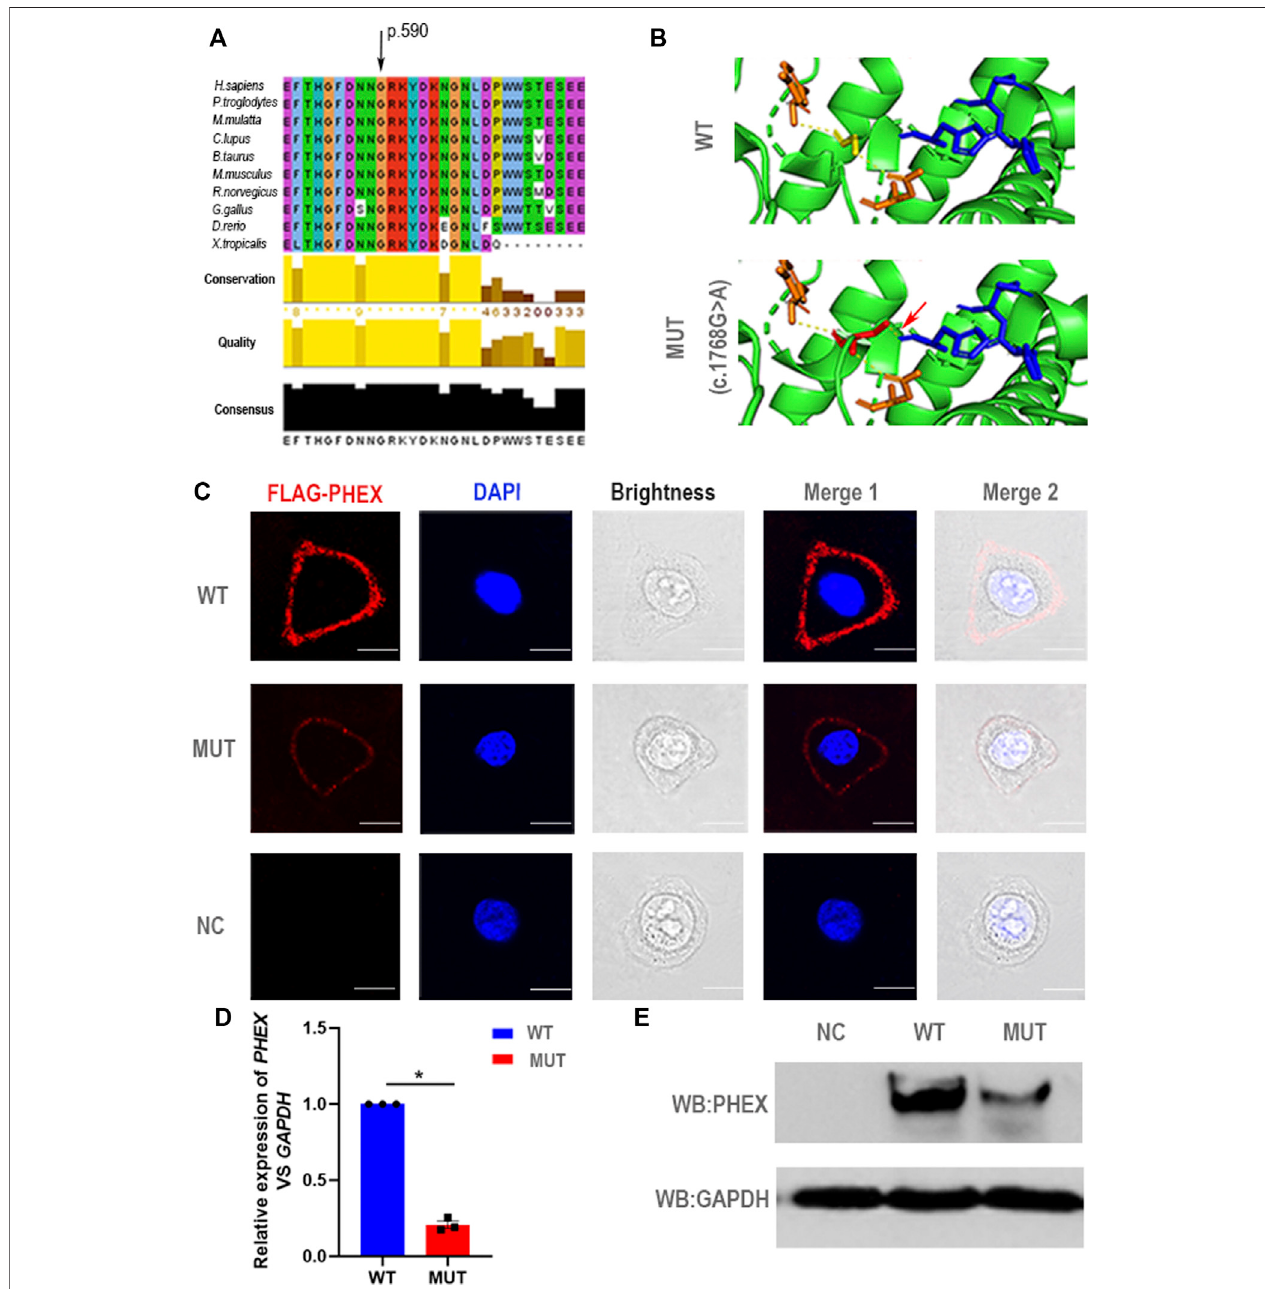
FIGURE3| Negativeeffect ofthenovelmutationin PHE X. (A) Themutant positionwedetected ishighly conserved amongmany species. (B) Structuralillustration of the missense mutation in PHEX . The mutation site in the wild-type PHEX protein model (WT) and mutant PHEX protein model (MUT) are shown as sticks and highlighted in yellow and red. The interrelated putative zinc-binding sites are also represented by sticks and colored in blue. The polar contacts of thetargetresidues are shownasyellowdashedlines,andrelativeaminoacidsareshownasorangesticks.Inthewild-typeprotein,Gly590formstwopolarcontactspredictedbyPyMOL; while in the mutant protein, Ser590 forms three polar contacts due to the addition of one polar contact with His584 that was deemed to be a zinc-binding site predicted byPyMOL. (C) Theimmuno fl uorescentdistributionofPHEXprotein.ThedeclineexpressionlevelofPHEXproteinwasnotedusingimmuno fl uorescencestainingofHeLa cells transfected with mutant- PHEX plasmid compared to cells transfected with WT- PHEX plasmid (red, FLAG-PHEX; blue, DAPI). Scale bars represent 10 μ m. Three independent experiments were performed. (D) Using qPCR, we observed that PHEX mRNA expression levels in the cultured HeLa cells transfected with mutant- PHEX plasmid were sharply attenuated compared to the cells transfected with WT- PHEX plasmid. (nonparametric test; * p < 0.05; error bars, s.e.m.). Three independent experiments were performed. (E) The western blotting results showed that PHEX protein was scarcely detectable in HeLa cells transfected with mutant- PHEX plasmid compared with the cells transfected with WT- PHEX plasmid. Three independent experiments were performed.